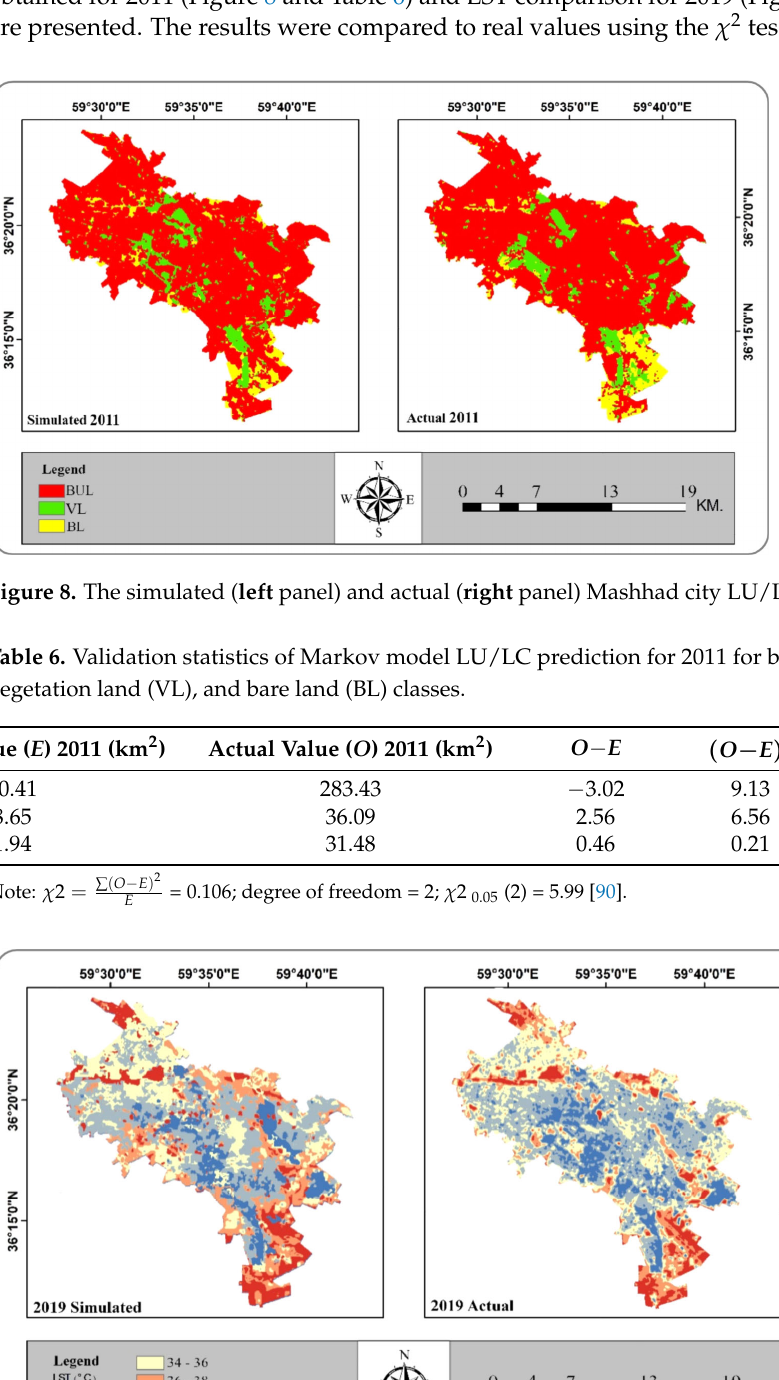
Table 6. Validation statistics of Markov model LU/LC prediction for 2011 for built-up land (BUL), vegetation land (VL), and bare land (BL) classes.